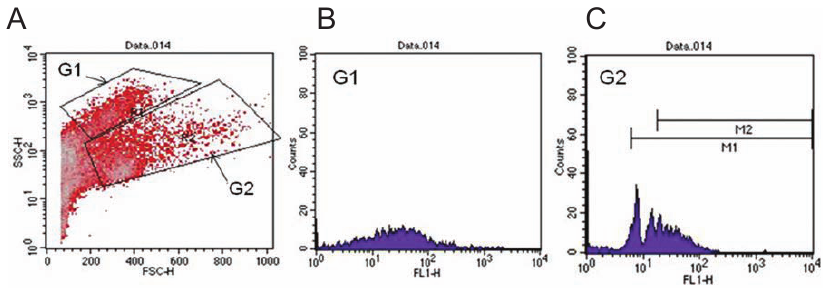
Figure 1. Pattern (A) and fluorescence histograms of Eisenia andrei cœlomocytes after the phagocytosis assay (B: Chloragocytes, C: amœbocytes, M1: cells have engulfed one bead and more, M2: cells have engulfed three beads and more).